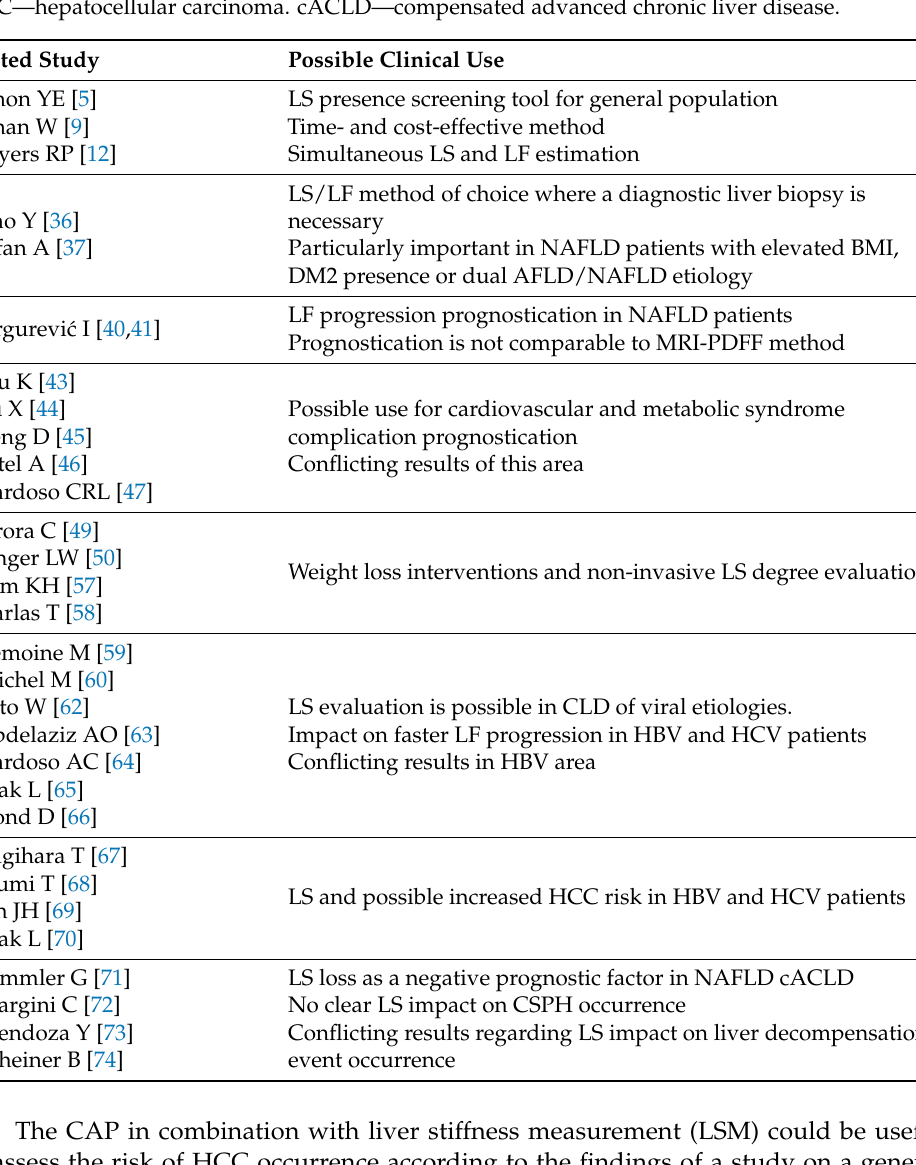
Table 3. Clinical applicability of presented quantitative US methods. Majority of the data are represented by the use of CAP. LS—liver steatosis. LF—liver fibrosis. NAFLD—non-alcoholic